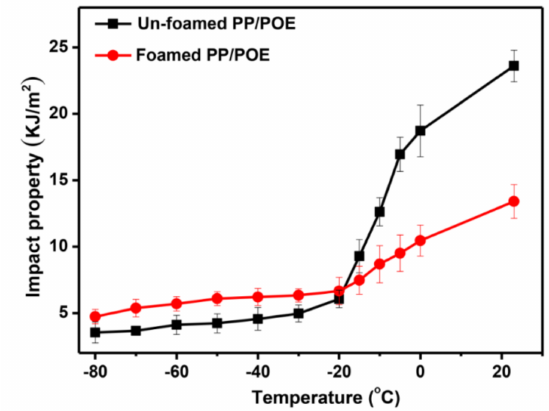
Figure 8. Analysis of low-temperature impact properties of PP/POE (20 wt %)